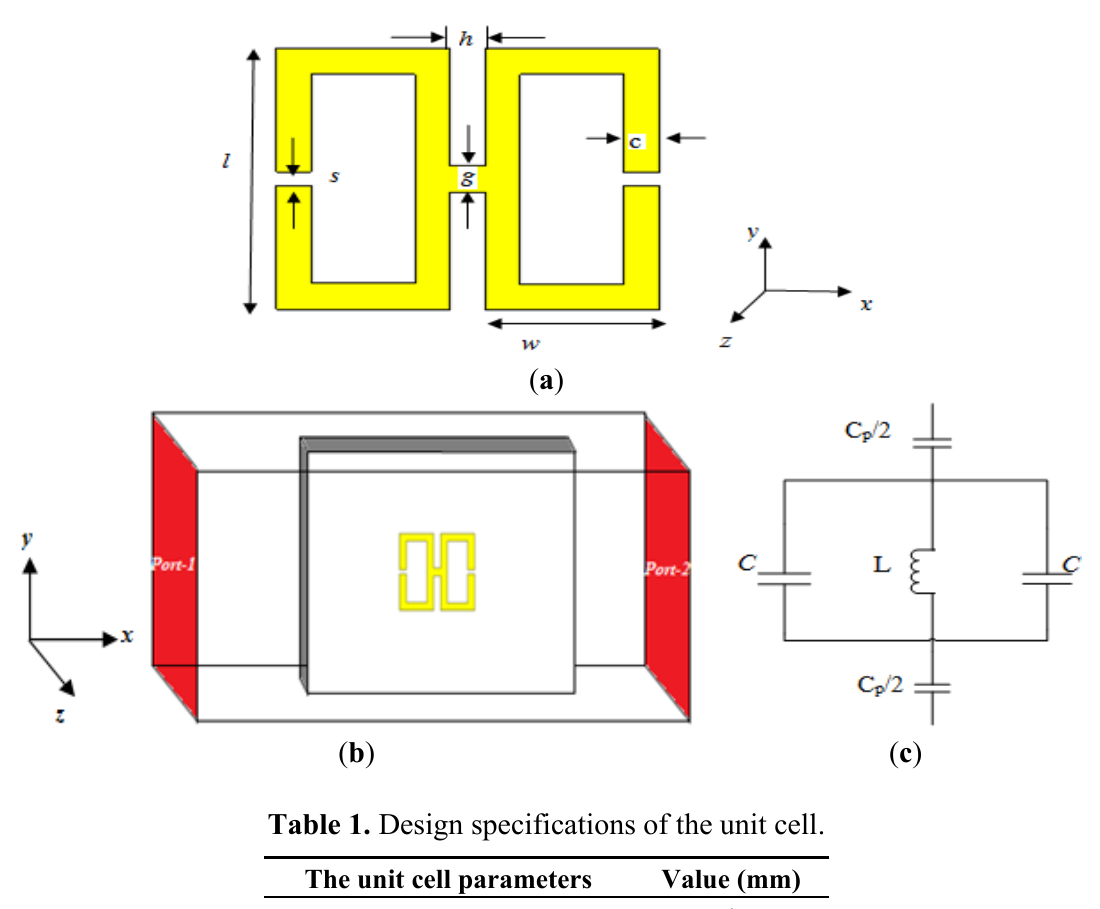
( c ) equivalent circuit of the unit cell.